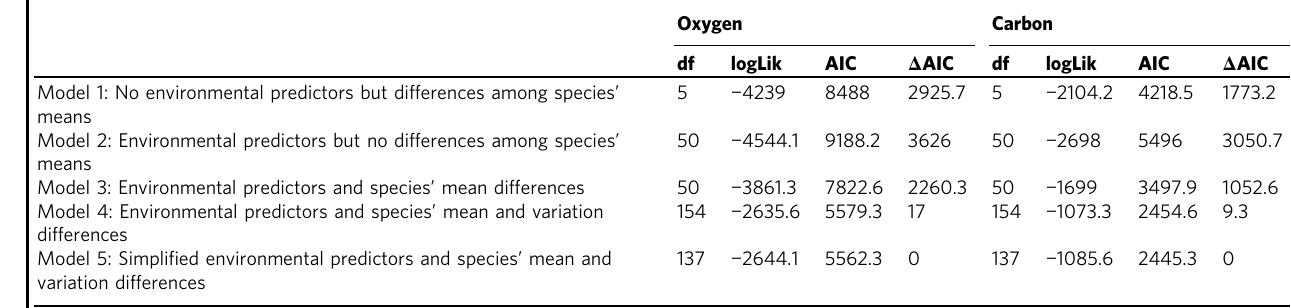
Table 1 Improvement in model likelihood with increasing model